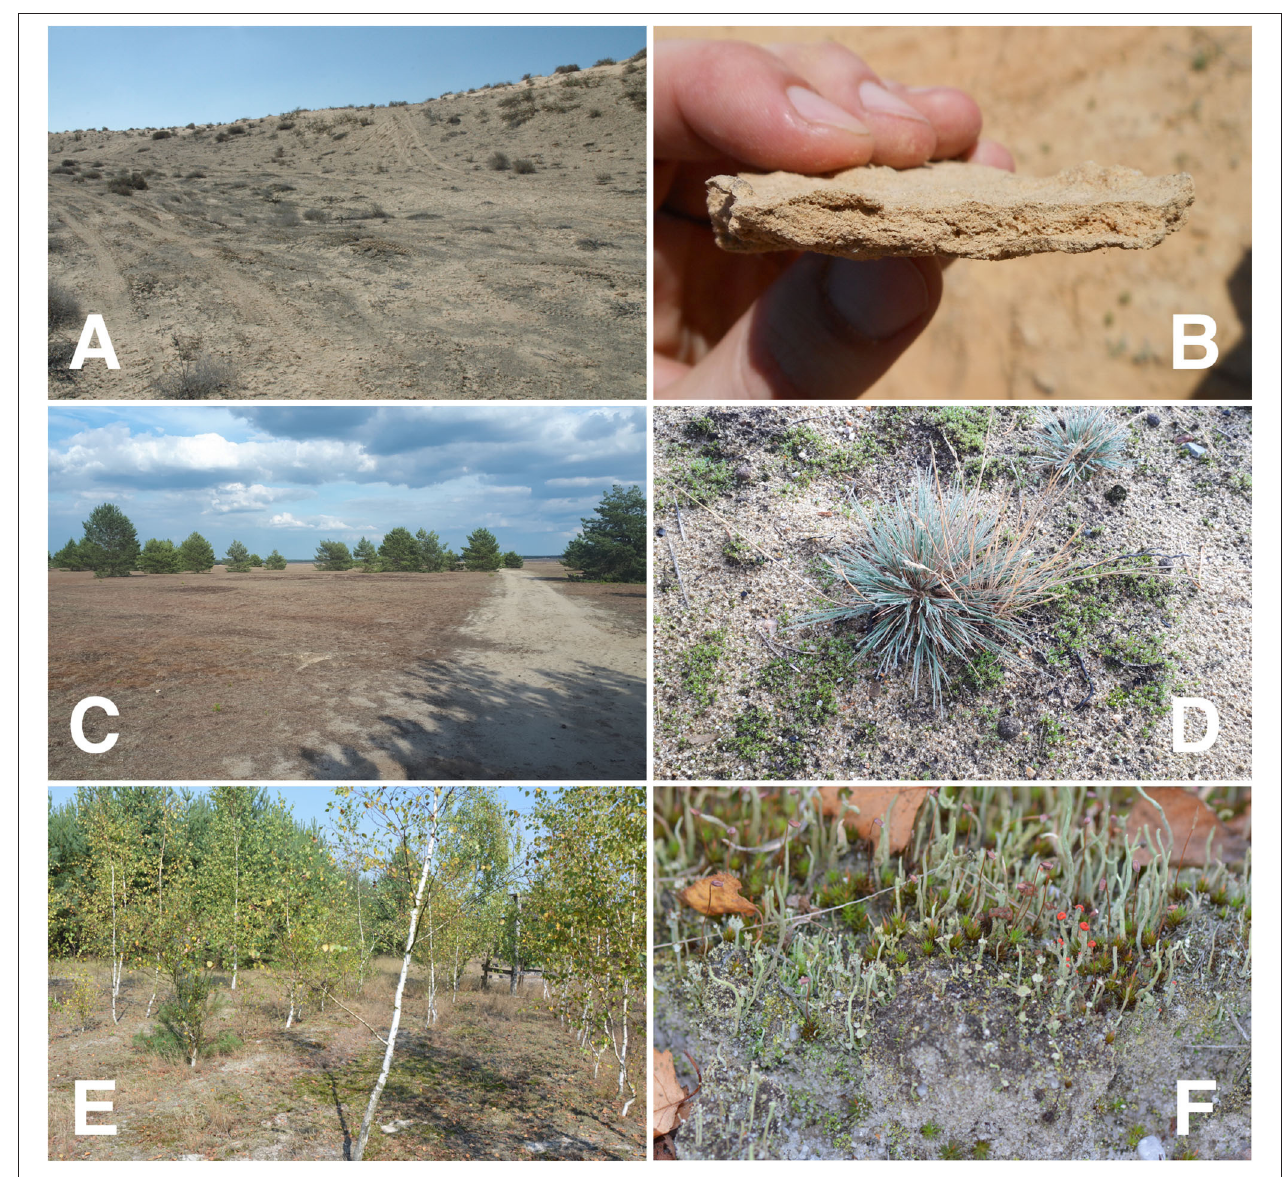
FIGURE 1 | Examples of different BSC in disturbed ecosystems (A) Biological soil crusts re-covered after disturbance by military vehicles in the Nizzana arid dunes of the north-western Negev, Israel, (B) Multi-layered cyanobacterial BSC in Nizzana, (C) Soil lichens- and moss-dominated BSC covering large areas of the sandy soils in a temperate dry grassland in a formerly disturbed military training area (Lieberoser Heide, Brandenburg, NE Germany), (D) Early successional stages of green algae and moss BSC established around gray hair-grass ( Corynephorus canescens ) in a temperate dry grassland, (E) Reclaimed post-mining site in Schlabendorf, Brandenburg, Germany is covered by soil lichen-moss communities mainly Cladonia spec. (F) (Gypser et al.,